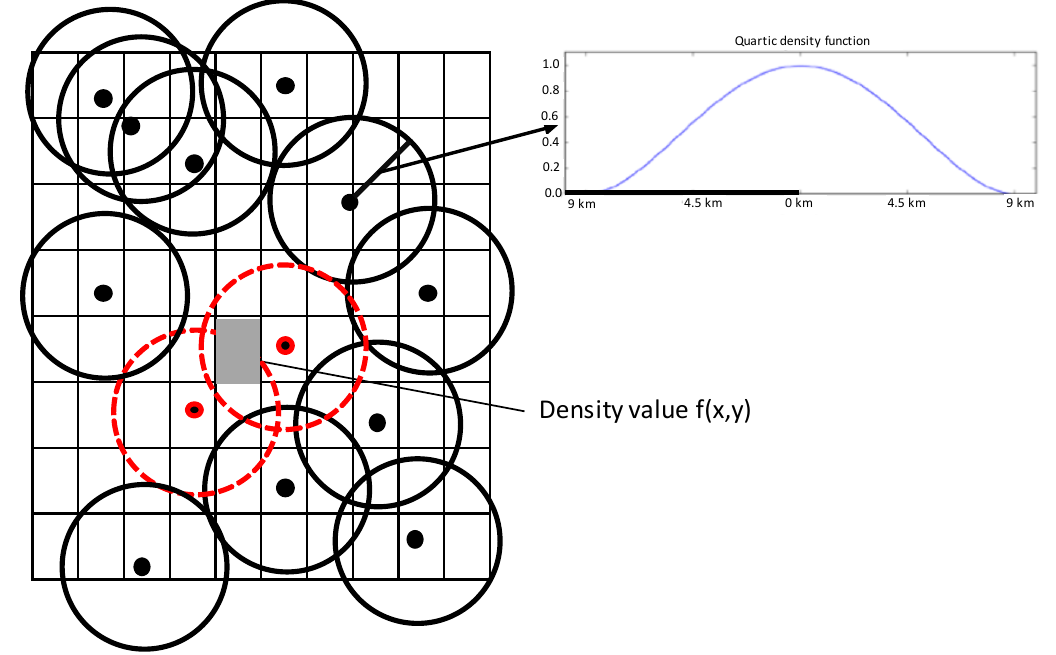
Figure 1. An illustration of the density value f ( x , y ) calculations over raster data and the quartic kernel function used ( K ), with a bandwidth of 9 km.